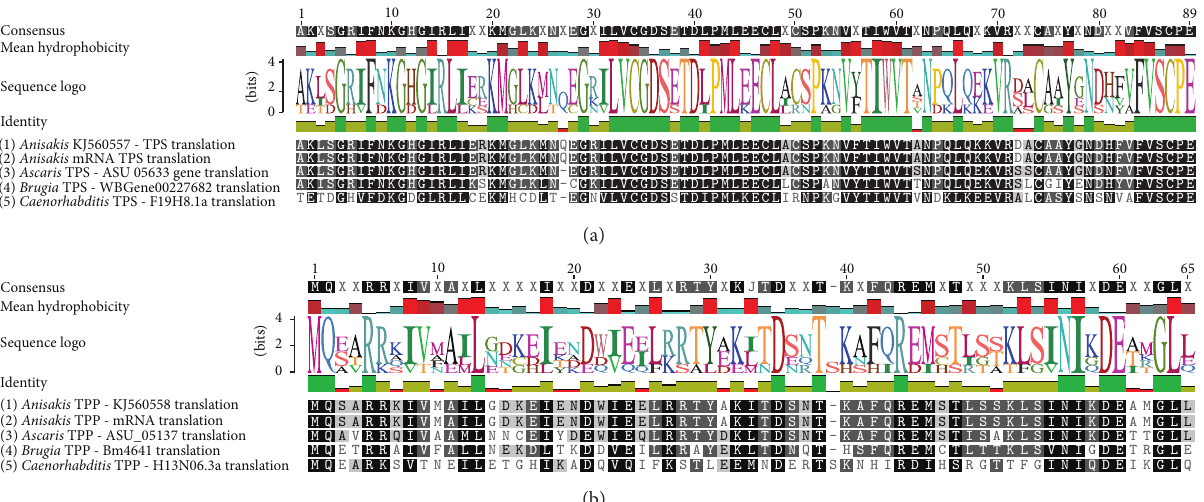
Figure 1: Multiple alignment of predicted partial deduced amino acid sequences of trehalose-6-phosphate synthase (a) and trehalose-6- phosphate phosphatase (b) from nematodes: third-stage (L3) larvae of Anisakis simplex , Caenorhabditis elegans , Brugia malayi , and Ascaris suum . The first line shows the consensus sequence of numbers amino acid position. Below (mean hydrophobicity) is a histogram of the hydrophobicity of individual amino acids. The line sequence logo is a consensus sequence where the size of the symbol of the amino acid determines its stability in its use position (this value also describes a line identity), and each amino acid is indicated by another color. Tinting the background of individual items in sequence on alignment determines similarity in position on all